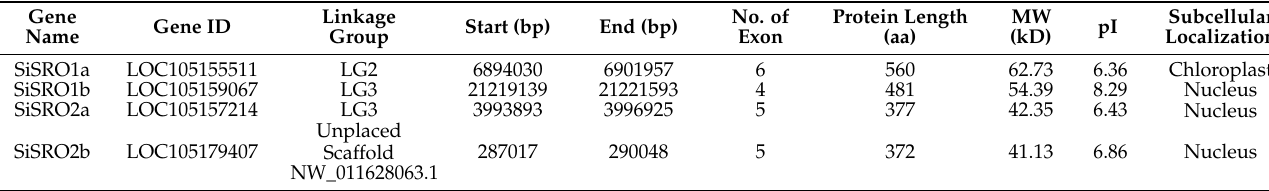
Table 1. SRO gene family in sesame.